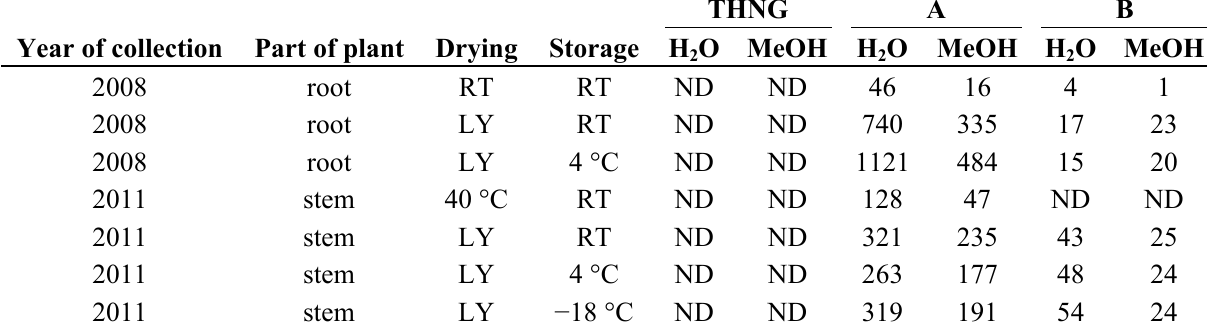
Table 2. The content of 1,2,4-trihydroxynaphthalene-1- O -glucoside (THNG), 2-hydroxy- 1,4-naphthoquinone ( A ) and 2-methoxy-1,4-naphthoquinone ( B ) in Impatiens glandulifera Royle (mg/kg) after subsequent extraction (water followed by